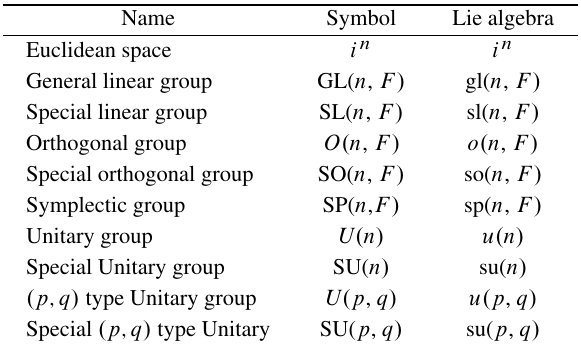
Table 1 Parameter of Lie groups and Lie algebras.